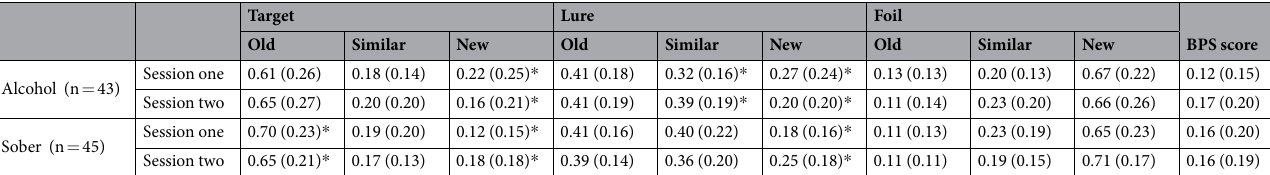
Table 2. Hit Rates for Each Stimulus and Response Type, as well as BPS Scores (Means and SD) During the Memory Anterograde task in Session One and Two between the Alcohol and Sober Condition. * Significant at p < 0.05. ** Significant at p < 0.001. Accurate hit rates are reflected by correctly responding to the stimulus targets, lures, or foils as “old”, “similar”, or “new”, respectively, with higher scores reflecting proportion of hits for each. False alarms to both lures (“old”|lure) and foils (“old”|foil), can also be observed, as well as incorrect “similar” responses to targets (“similar”|target) and foils (“similar”|foil).